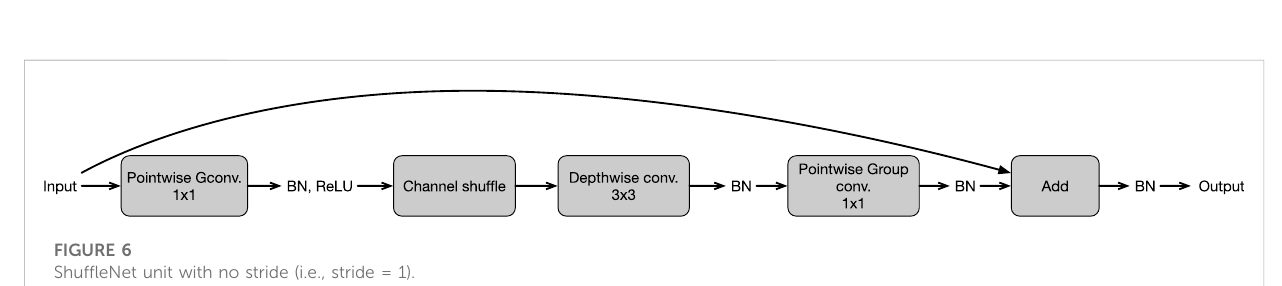
FIGURE 6 Shuf fl eNet unit with no stride (i.e., stride =